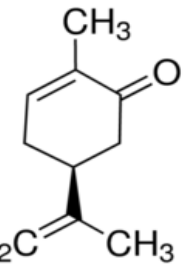
Figure 1. Chemical structure of